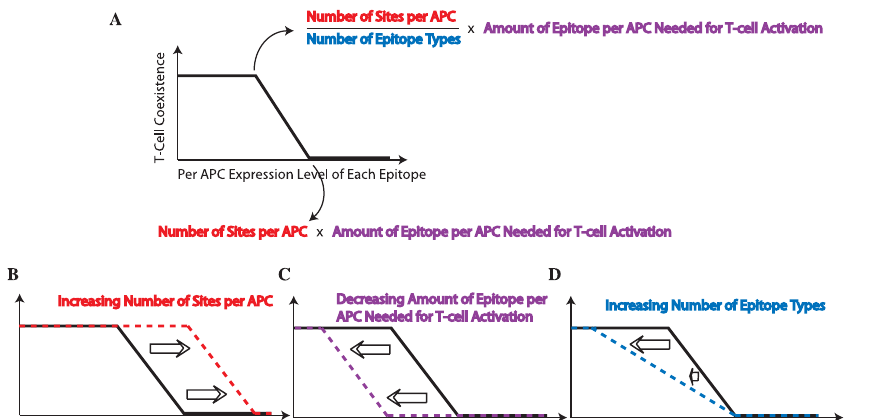
Figure 6. The Effect of Varying APC Size, T Cell Sensitivity, and the Diversity of Displayed Epitopes on T Cell Coexistence The per APC epitope expression level of each epitope up to which T cell coexistence is maximal depends on the size of APCs, the number of different epitope types that are presented, and the amount of epitope a T cell needs to become activated. The epitope expression level above which the immunodominant T cell population outcompetes all others solely depends on the APC size and on the amount of epitope required for T cell activation (A). In the three graphs below, the effect of changing any one of these parameters is shown. (B) The larger the surface area of APCs, the wider the range of per APC epitope expression levels for which coexistence of T cells is maximal. (C) The more sensitive T cells are to epitope (i.e . , the lower the amount of epitope a T cell requires to become activated), the more narrow the range of epitope expression levels with maximal coexistence of T cell populations of different epitope specificity. (D) The number of different pathogen epitopes that are presented on an APC effects the per APC epitope expression level up to which T cell coexistence is maximal, but not the level at which the immunodominant T cell specificity outcompetes the other epitope-specific T cell populations. The higher the number of different epitope types, the more narrow the range of per APC epitope expression levels at which T cell coexistence is maximal. DOI: